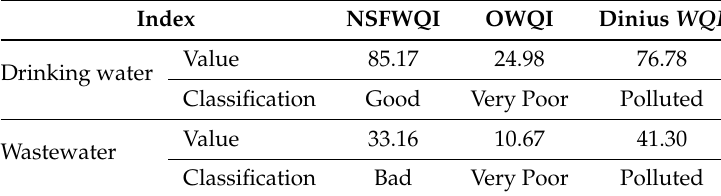
Table 4. Comparison between water quality indices using data from Colombia [59].